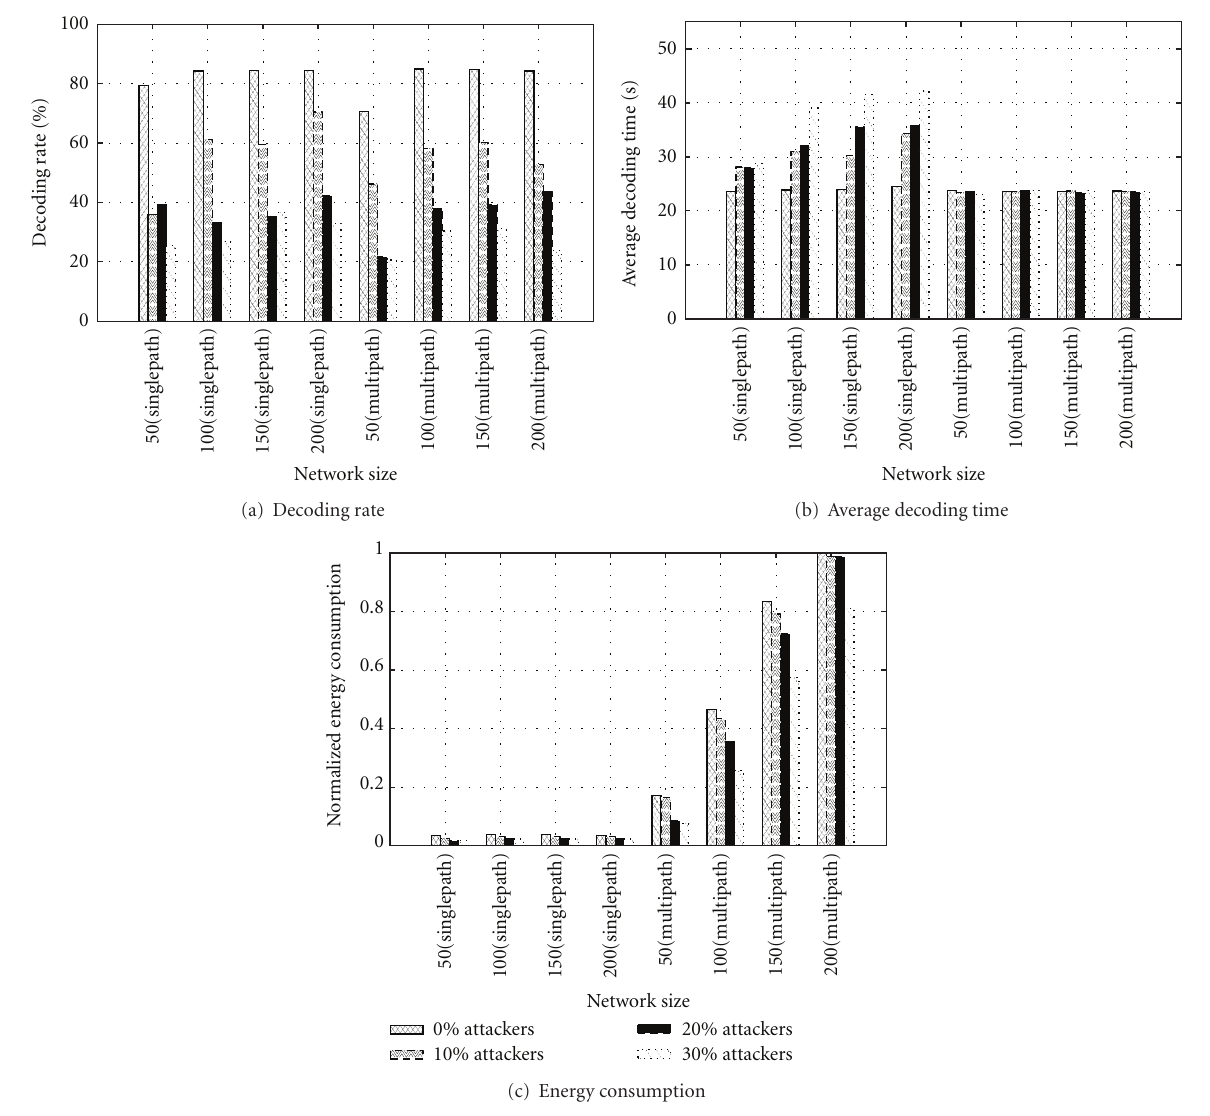
Figure 4: Performance results when single path and multipath network coding are confronting to selective forwarding attackers and to flooding